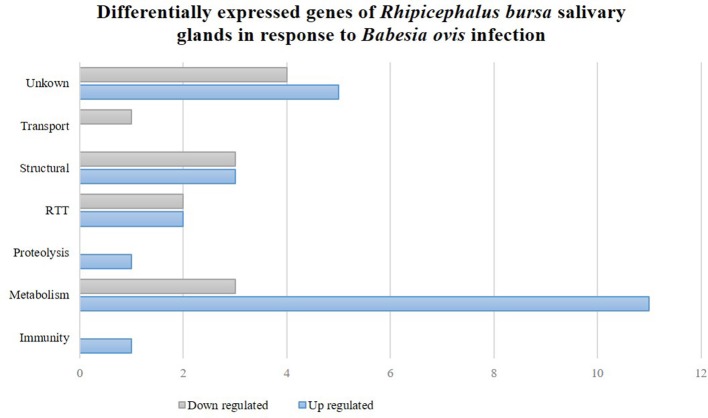
Rhipicephalus bursa SG transcriptional response to Babesia ovis infection based on Gene Ontology functional classes assignments of encoded proteins. Gray bars represent down regulated genes and blue bars represent up regulated genes with statistical significance (P < 0.05).